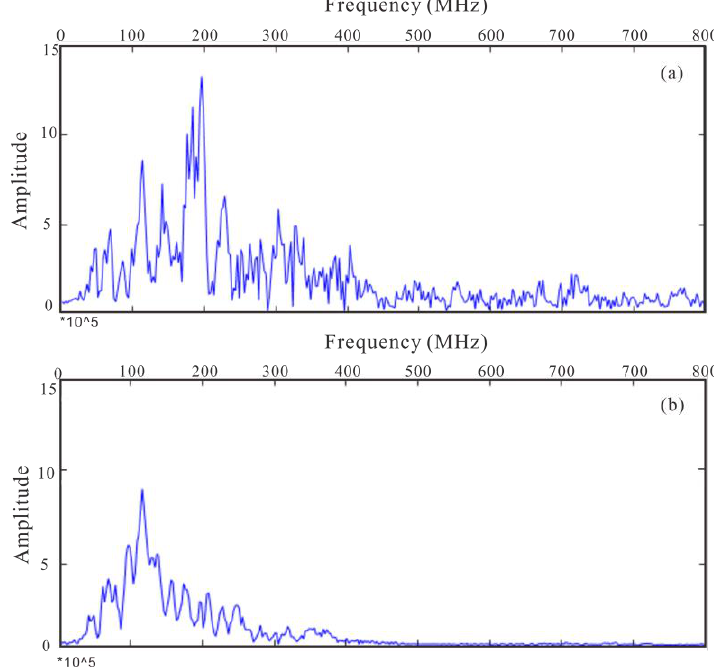
Figure 4. Data spectrum analysis. ( a ) Raw data; ( b ) processed data.